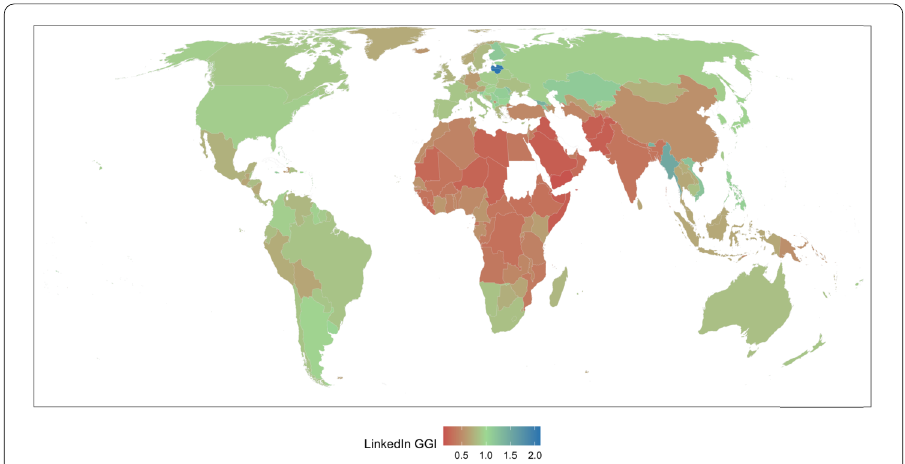
Figure 1 LinkedIn Gender Gap Index (GGI), computed as the female-to-male ratio of LinkedIn users in a country, across the world (New Equal Earth